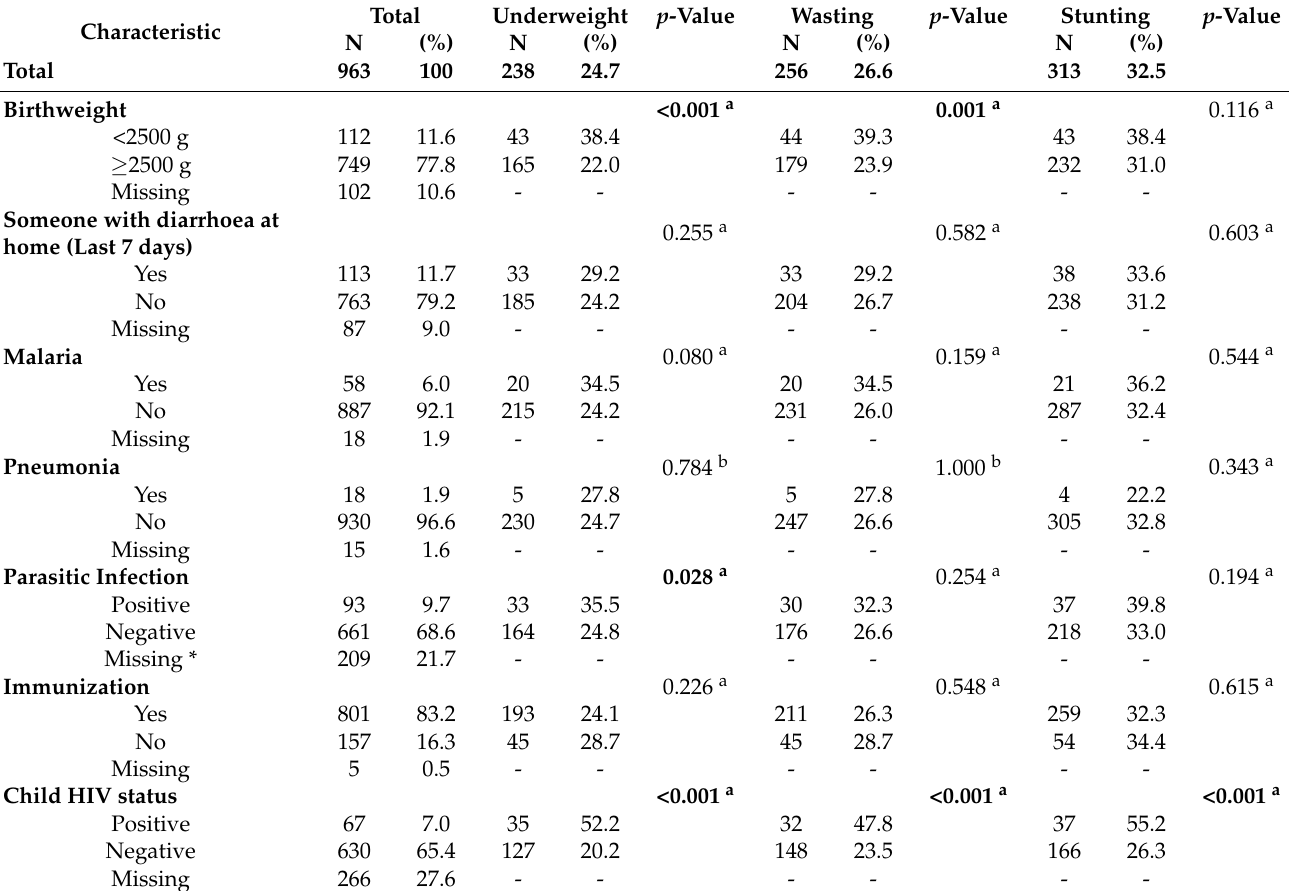
Table 2. Clinical characteristics of children and frequency of undernutrition status by category.